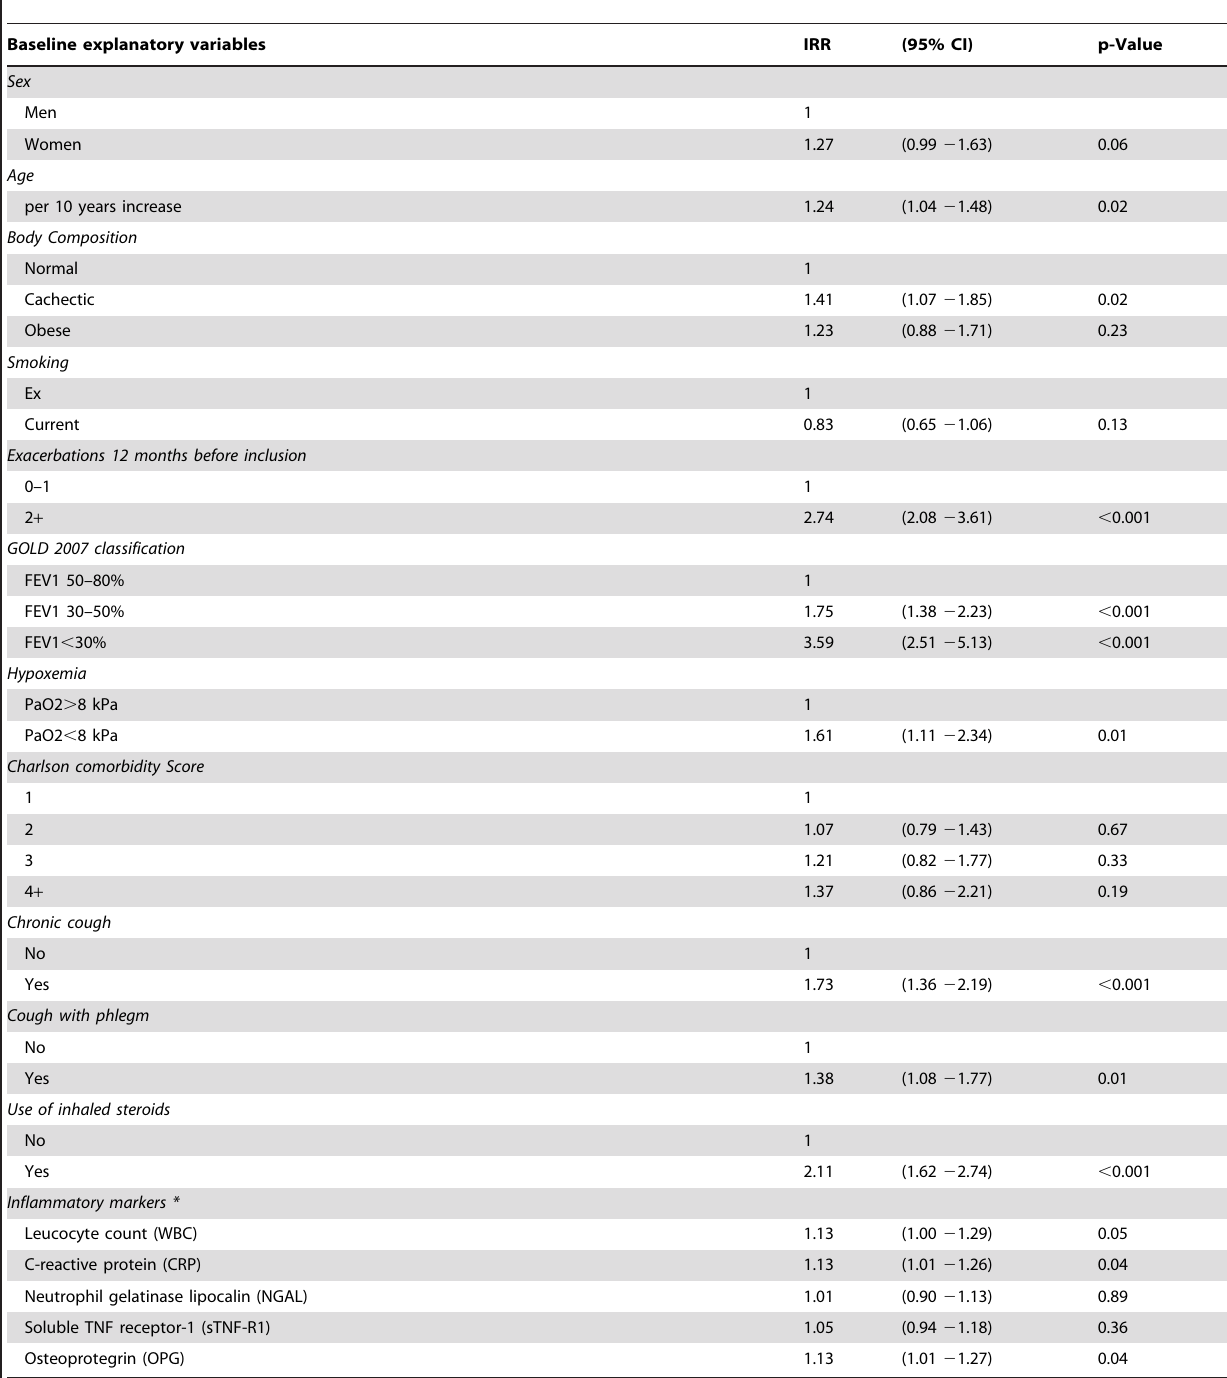
Table 2. Bivariate predictors of the annual incidence rate ratio (IRR) of moderate or severe COPD exacerbations, estimated by a random effects negative binomial